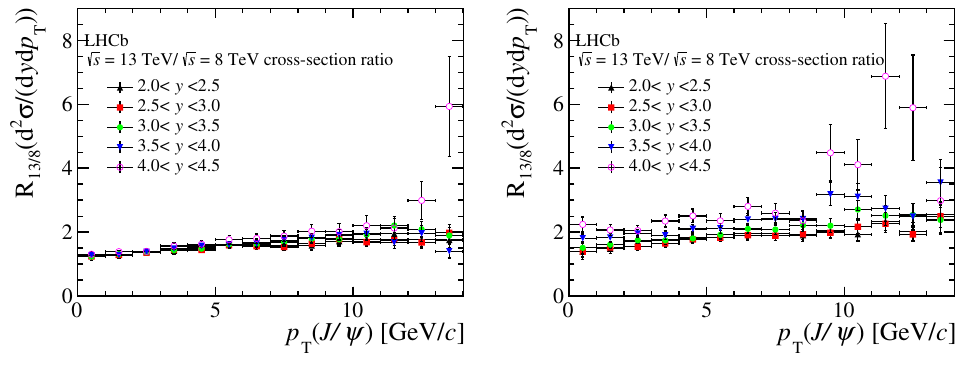
p p s = 13 TeV and s =